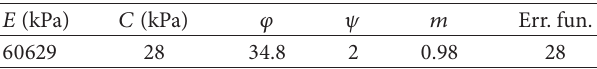
Table 8: The best set of soil constitutive model parameters obtained by systematic inverse analysis after performing sensitivity analysis and removing the unimportant parameter.